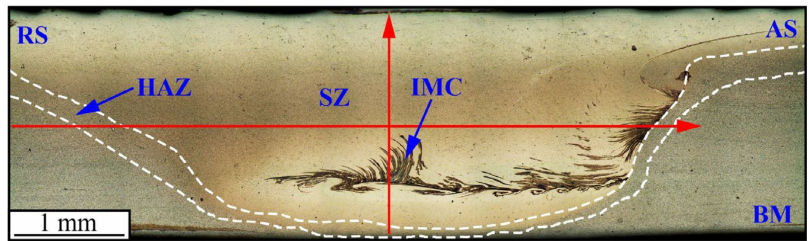
Figure 7. Cross-sectional metallographic image of specimen 2. Red lines identify the lines of microhardness profiles.